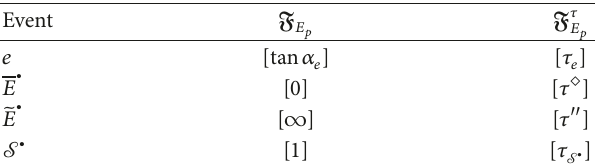
Table 5: The change of projective frame and the corresponding